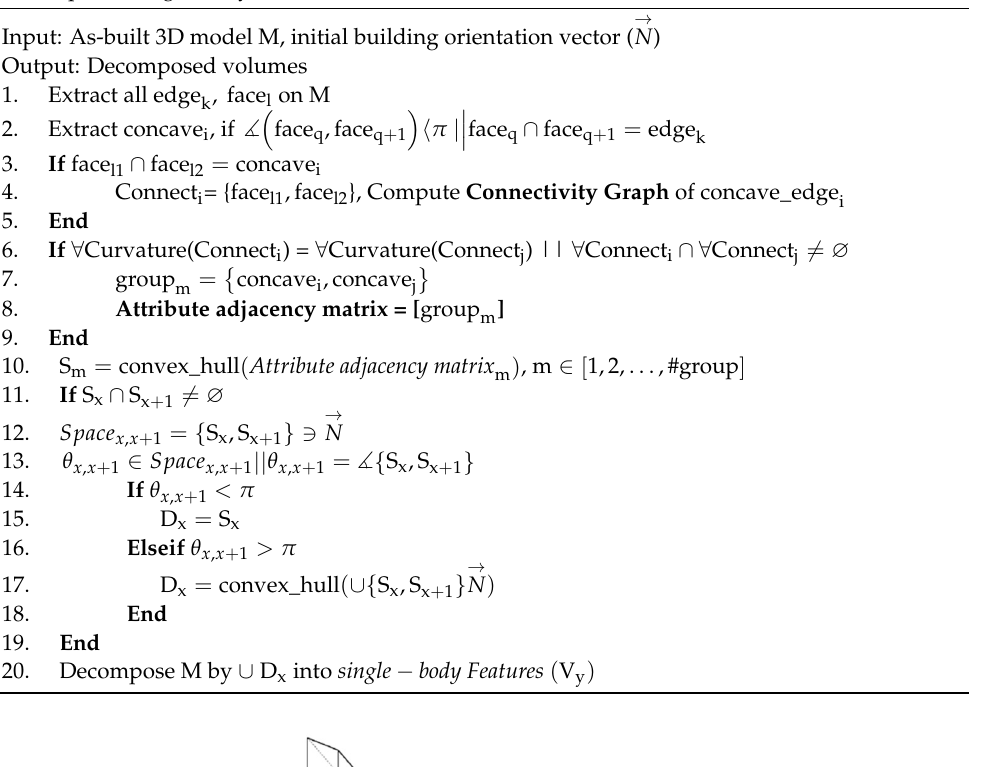
Algorithm 1: Decomposition of as-built into single-body features. Autonomous creation of decomposed single-body features.